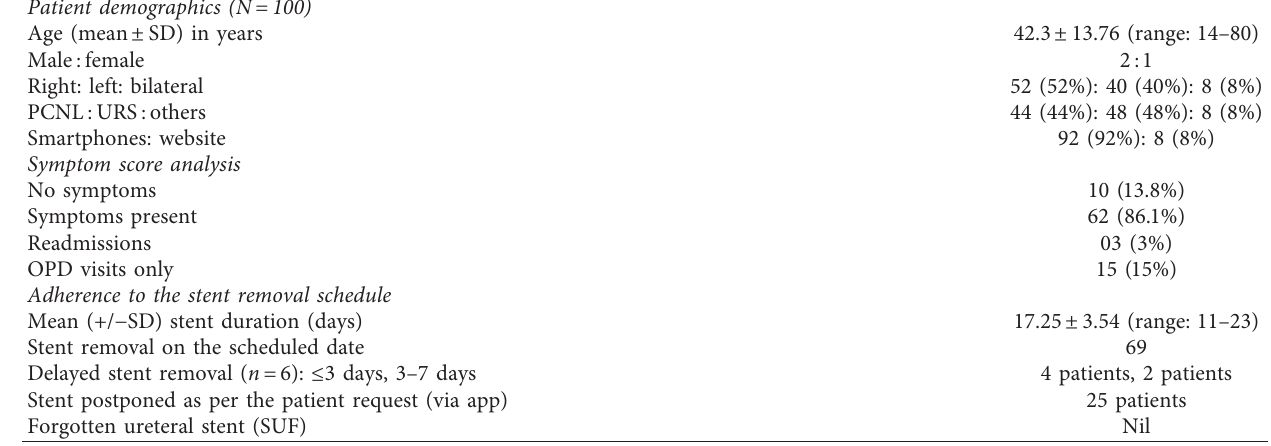
Table 1: Patient demographics, symptom score analysis, and adherence to the schedule.